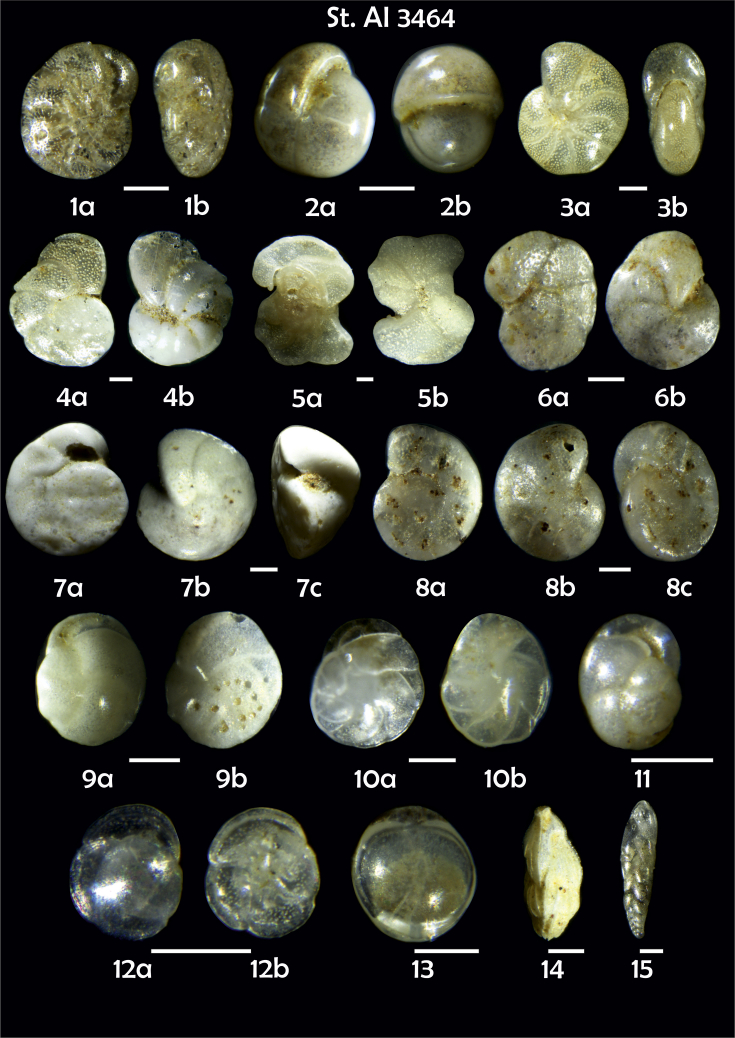
Station 34641Elphidium excavatum, a lateral view, b apertural view. 2Pullenia bulloides, a side view, b apertural view. 3Melonis barleeanus,a side view, b apertural view. 4Cibicidoides sp., a spiral view, b umbilical view. 5Cibicidoides sp., a spiral view, b umbilical view. 6C. lobatulus, a umbilical view, b spiral view. 7Cibicides refulgens, a umbilical view, b spiral view, c apertural view. 8C. wuellerstorfi, a umbilical view, b spiral view, c apertural view. 9Cassidulina laevigata, a apertural view, b lateral view. 10C. teretis, a apertural view, b lateral view. 11Globocassidulina subglobosa. 12Rosalina sp., a spiral view, b umbilical view. 13Fissurina sp. 14Trifarina angulosa. 15Bolivina earlandi. Scale 100 μm.